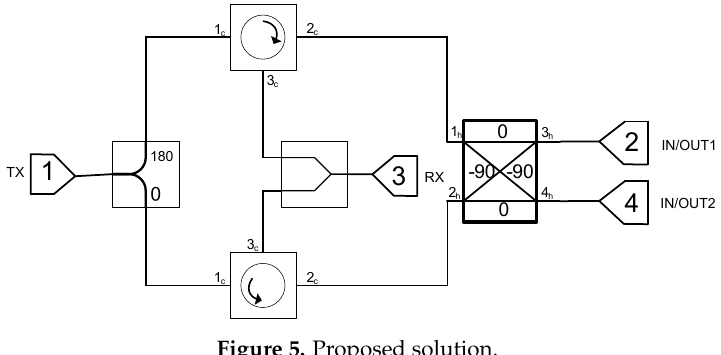
Figure 5. Proposed